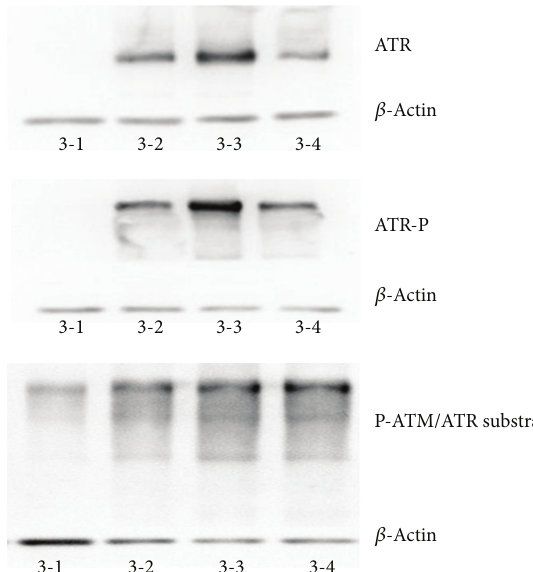
Figure 8: TNF- 𝛼 and IFN- 𝛾 increase activation of ATR in BMM- NCs. Legend: Sample 3-1: BMMNCs + 1640 media + 10% FBS. Sample 3-2: BMMNCs + 1640 media + 10% FBS + 100U TNF- 𝛼 , Sample 3-3: BMMNCs + 1640 media + 10% FBS + 200U TNF- 𝛼 , and Sample 3-4: BMMNCs + 1640 media + 10% FBS + 100U IFN- 𝛾